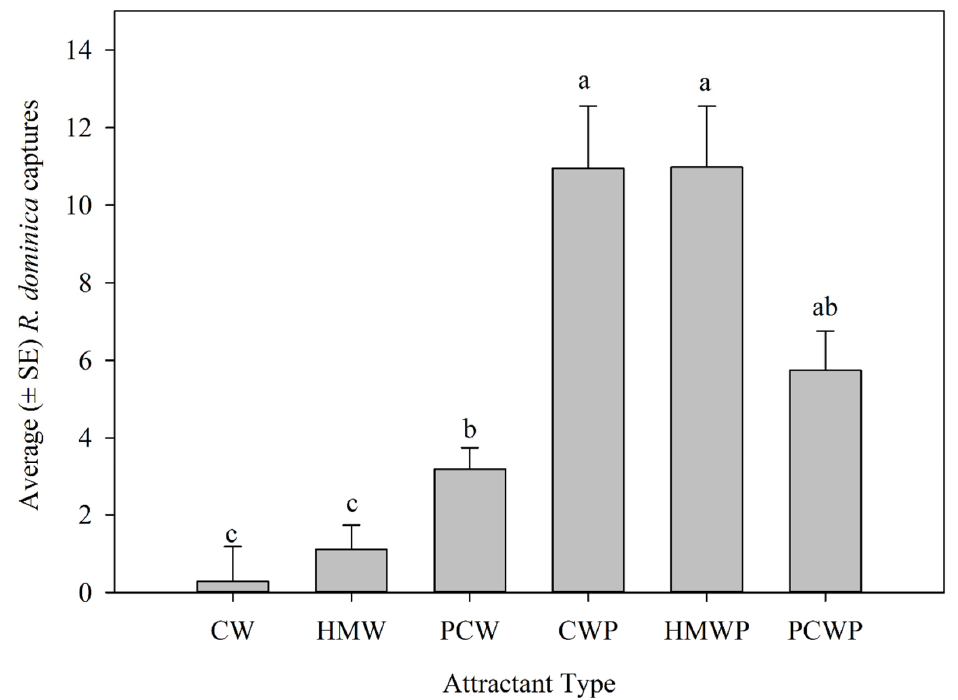
Figure 6. Mean (±SE) Rhyzopertha dominica captures over two years and three locations (native prairie, feed mill, and grain elevator) amongst six different attractants (CW: crimped wheat; HMW: high moisture wheat; PCW: preconditioned wheat; CWP: crimped wheat plus pheromone; HMWP: high moisture wheat plus pheromone; PCWP: preconditioned wheat plus pheromone). Different lowercase letters indicant significant differences among each attractant type ( F = 32.60; df = 5, 336; p < 0.0001, Tukey studentized range (HSD) test).